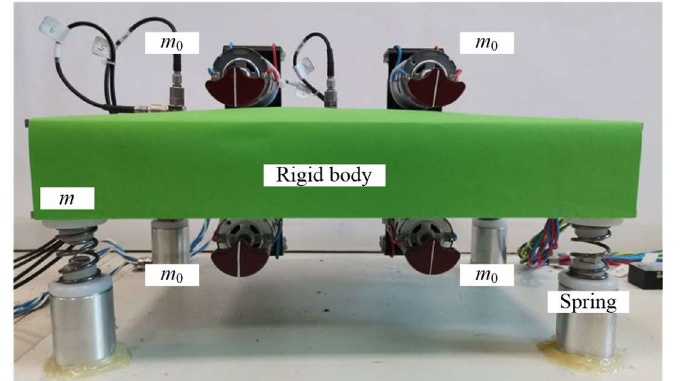
Figure 4. E xperimental machine. Figure 4. Experimental machine.